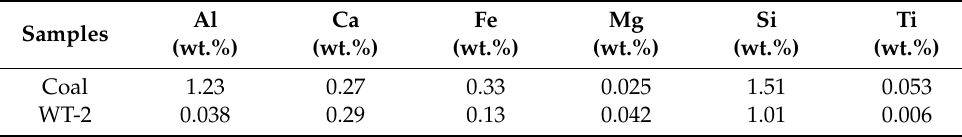
Table 2. Mineral compositions of coal and